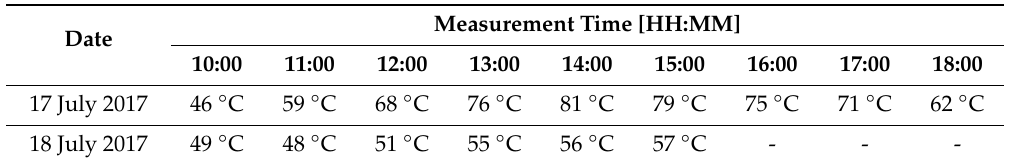
Table 1. Solar cells average temperature on surfaces for the covered CPC system (17 July 2017 and 18 July 2017) [43].